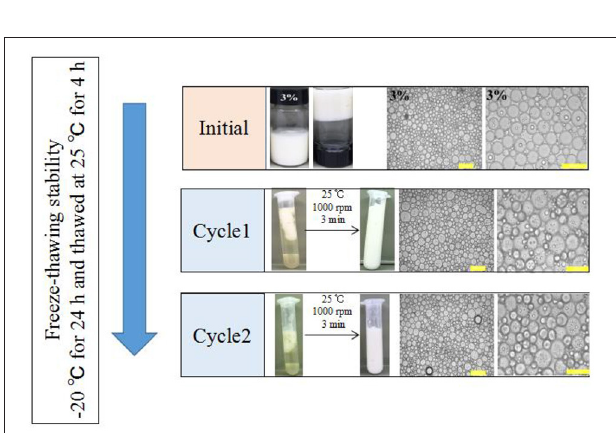
FIGURE 8 | Visual appearance and optical micrographs of the WSP-stabilized HIPEs at a fixed c value of 3 wt%, before or after two cycles of freeze-thaw treatment. The scale bars are 50 and 100 µ m, respectively. All the HIPEs were frozen at − 20 ◦ C for 24h and then thawed at 25 ◦ C for 2h. In all cases, the same emulsification process was performed using a one-pot homogenization at 10,000 rpm for 3min at room